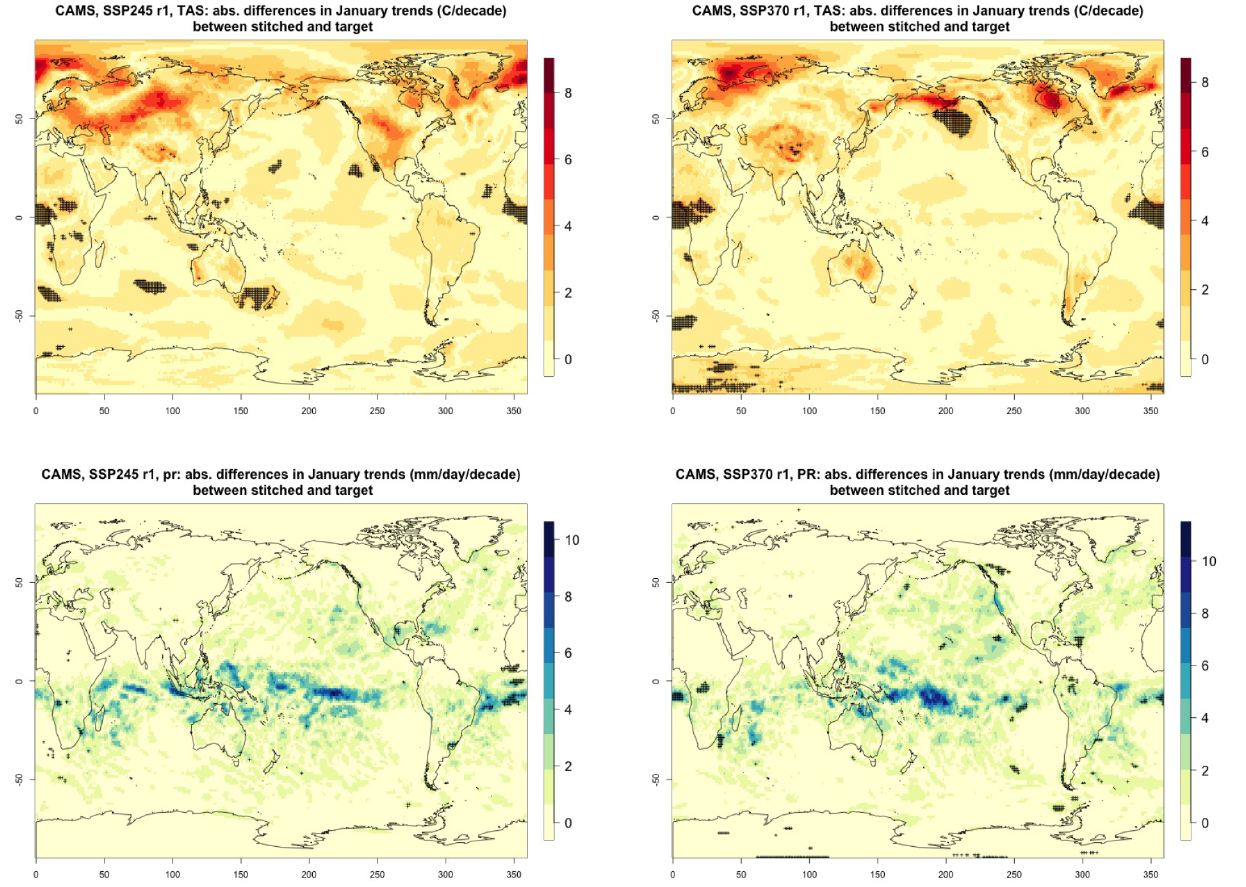
Figure C4. Absolute difference in decadal trends of January temperature (TAS) and precipitation (PR) between stitched and target realiza- tions. The value of the difference is expressed by the color scale, and we marked as significant with black crosses those locations where the 95% confidence intervals of the trends computed from target and stitched time series do not overlap, indicating statistically significant differences. Emulation of CAMS, January time series over 2015–2100, for SSP2-4.5 and